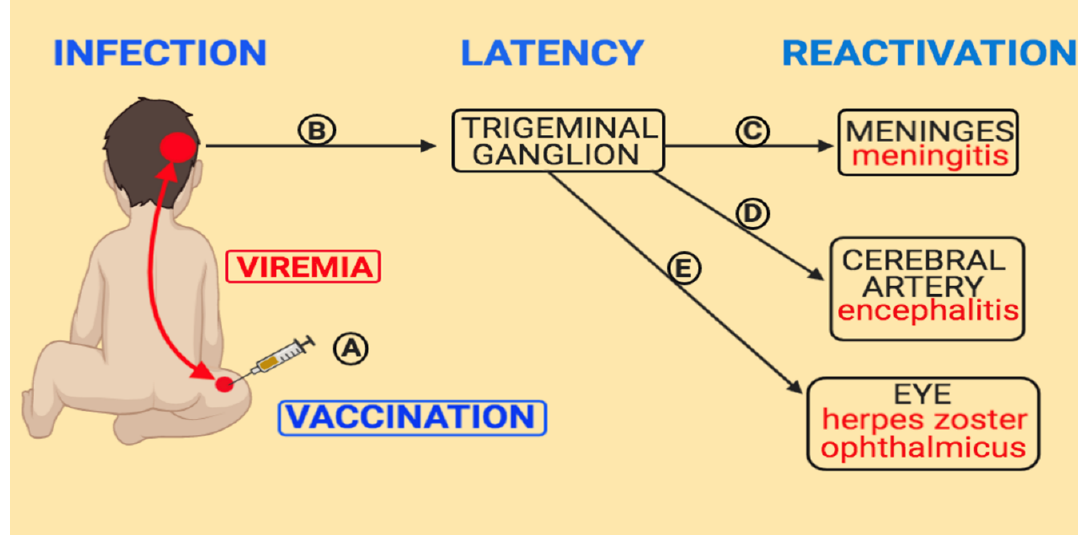
Figure 5. Pathogenesis of varicella vaccine meningitis following herpes zoster ophthalmicus. Following varicella vaccination of about 50% of young children, virus is carried within lymphocytes throughout the body ( A ). Some virus enters and become latent in the trigeminal ganglion ( B ). When this virus reactivates, it can be carried via a ff erent fibers to the meninges ( C ), cerebral arteries ( D ) and eye (herpes zoster ophthalmicus ( E